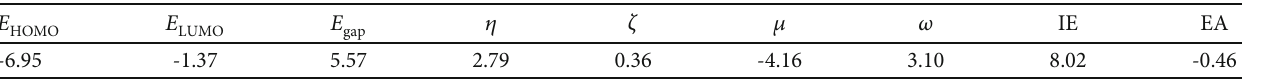
Figure 2: (a) Structure of CEX molecule as optimized at the PW6B95D3/Def2-TZVP level of theory. (b) HOMO; (c) LUMO of the CEX molecule. Table 3: DFT-based descriptors of the CEX molecule as calculated at the PW6B95D3/Def2-TZVP level of theory. The energy unit used in the table is